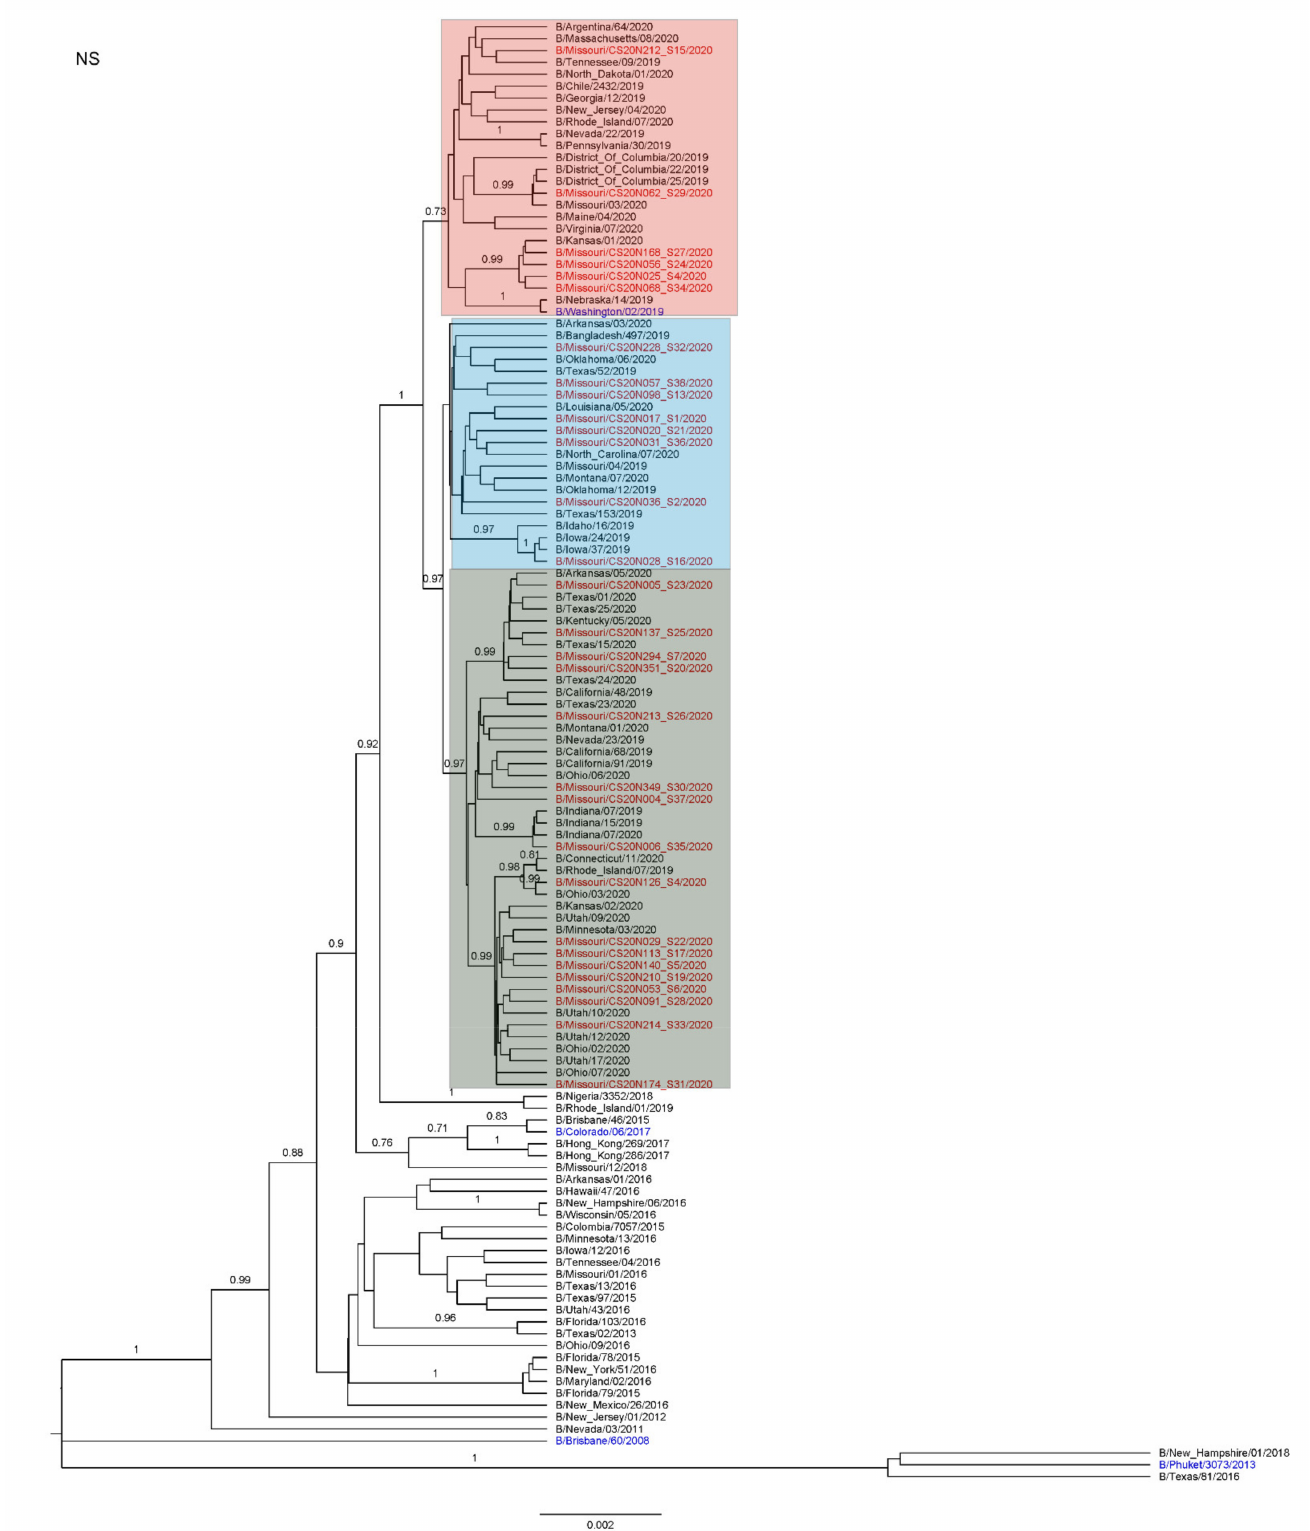
Figure A8. NS Tree. The phylogenetic analyses were performed by using BEAST2 with a Hasegawa–Kishino–Yano (HKY) substitution empirical model, strict clock model, and coalescent constant population prior. Branches with a posterior probability >0.70 were